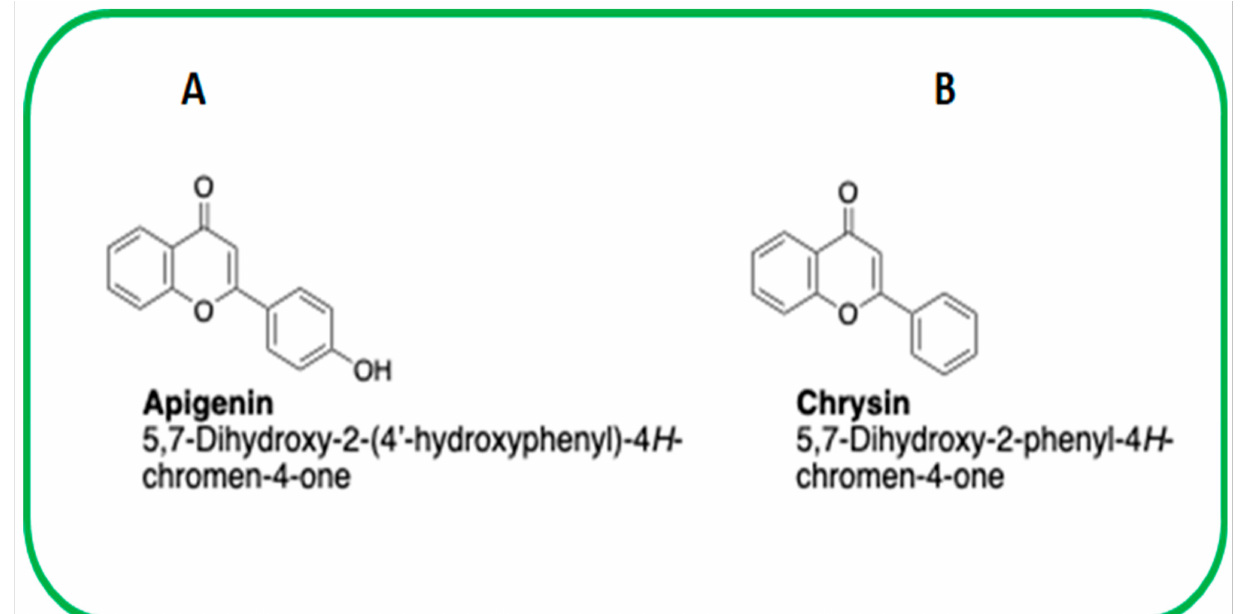
Figure 1. IUPAC nomenclature for structurally related flavonoids. ( A ) Apigenin is a 5,7-Dihydroxy-2- (4 (cid:48) -hydroxyphenyl)-4 H -chromen-4-one and ( B ) chrysin is a 5,7-Dihydroxy-2-phenyl-4 H